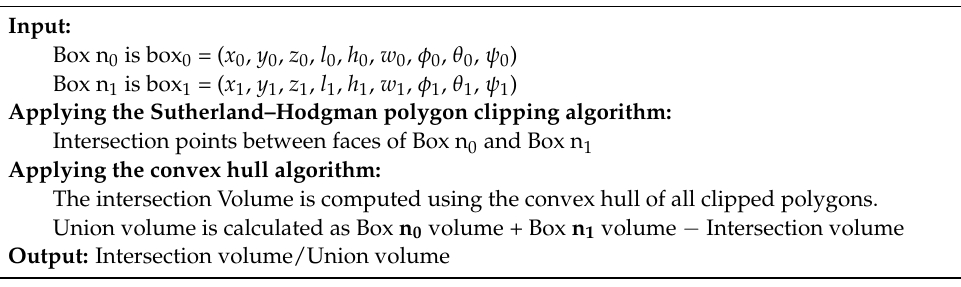
Algorithm 1 3D IoU values for general 3D-oriented boxes